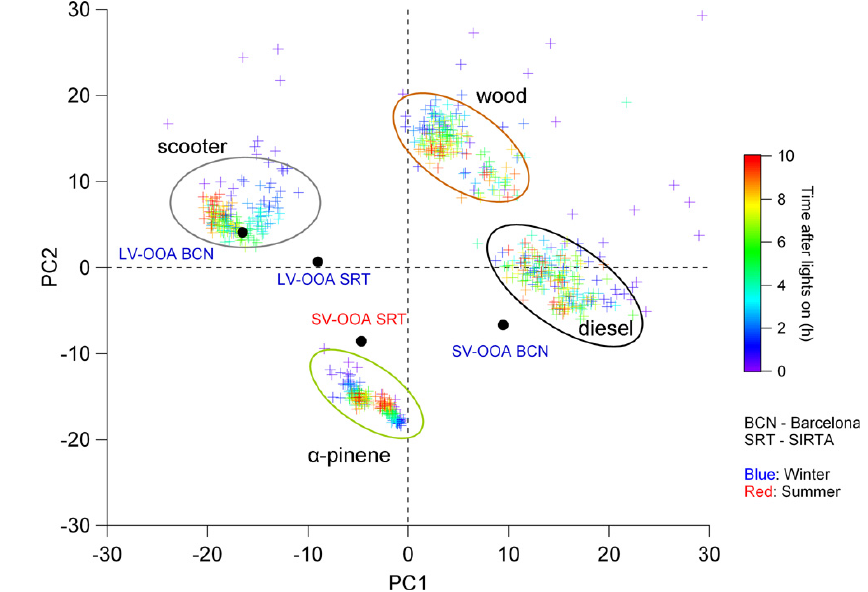
Fig. 10. PCA model based on the HR source spectra after five hours of aging. The data points of all eight experiments are projected and colored according to the aging time. The ovals are added to guide the eye and define where ∼ 95% of the data points fall. PMF resolved OOA spectra from different field campaigns are marked in red and blue text indicating summer and winter,